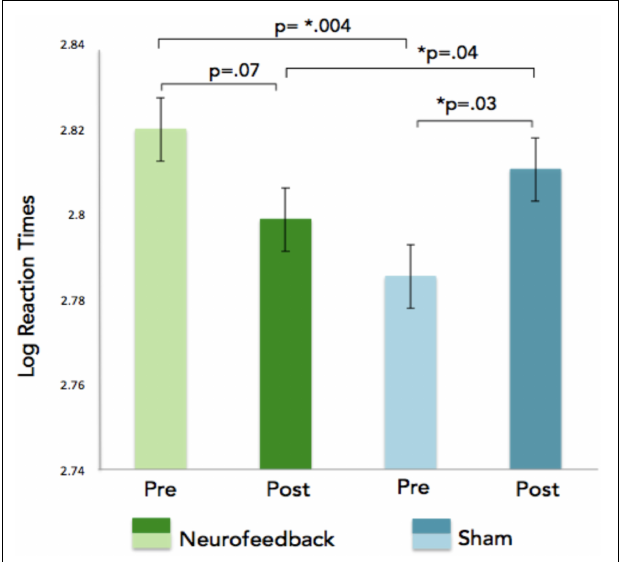
FIGURE 7 | Log reaction times are indicated on the x-axis for the n-back task. The GLM revealed a significant pre/post neurofeedback training interaction showing faster reaction times for correct n-back trials in the neurofeedback group as compared to the sham feedback group after neurofeedback